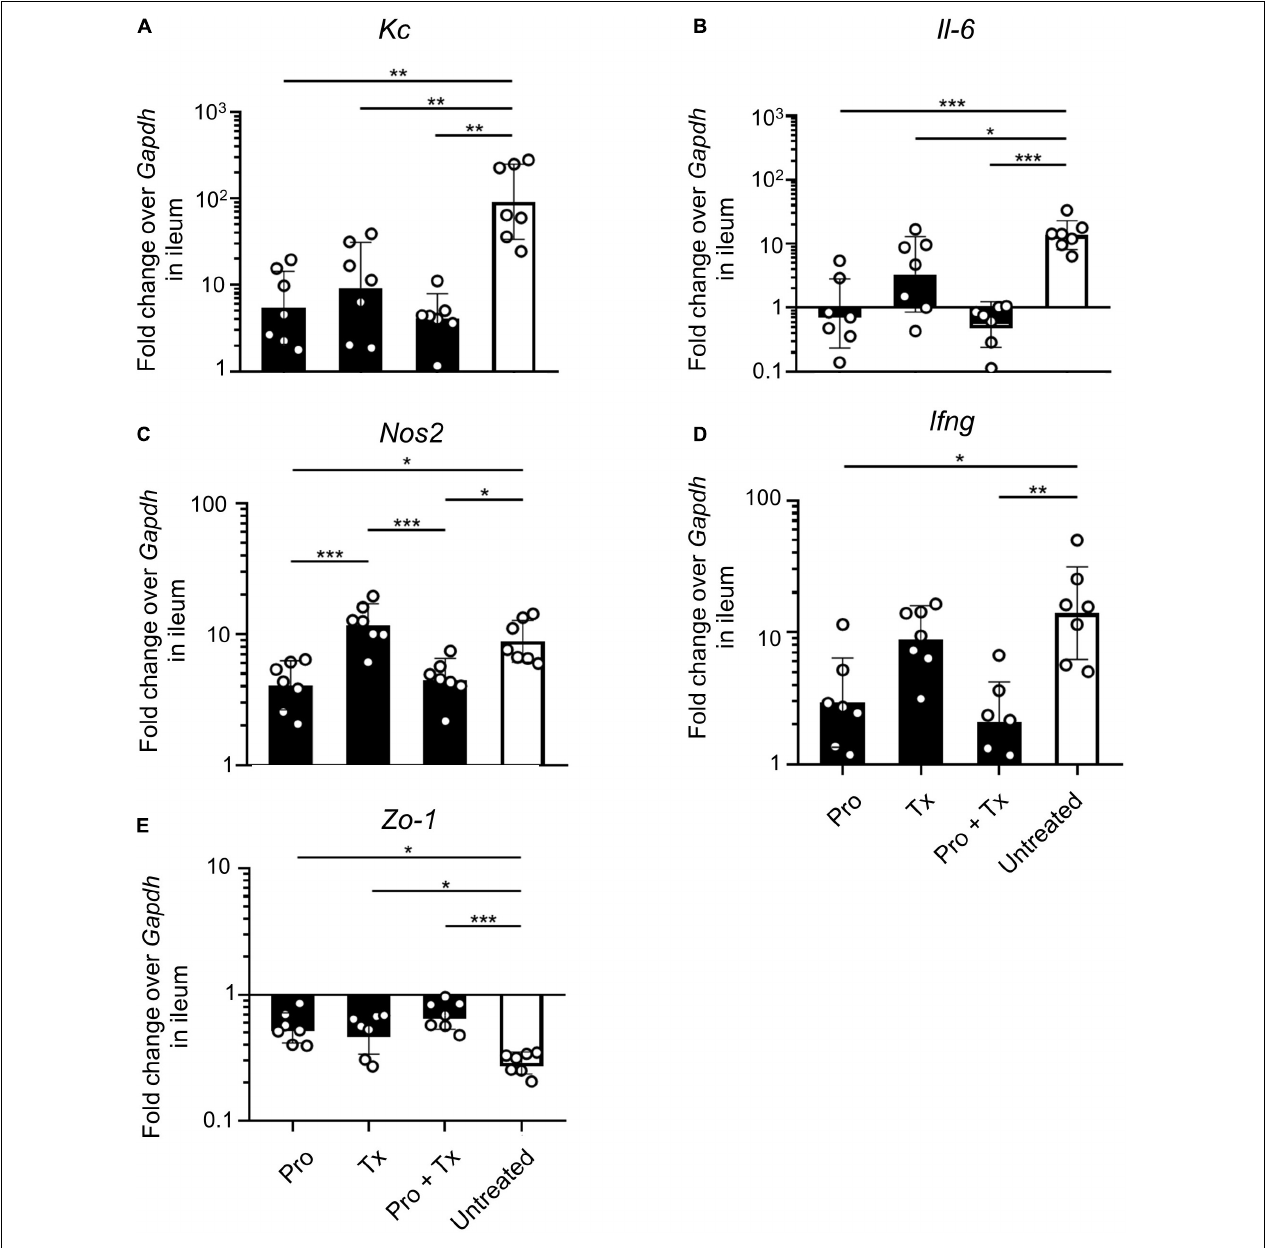
FIGURE 6 | Anti-inflammatory effect of L. reuteri KUB-AC5 on the STM-infected mouse ileum. At day 4 post infection, mouse ilea were collected and quantified for the fold change in mRNA expressions of pro-inflammatory cytokines ( Kc , Il-6 , and Ifng ), iNOS ( Nos2 ), and tight junction protein ( Zo-1 ) by qPCR. All genes were analyzed with the comparative Ct method over the housekeeping gene Gapdh . Bars represent geometric means ± SD. * P < 0.05, ** P < 0.01, and *** P < 0.001 compared to all other